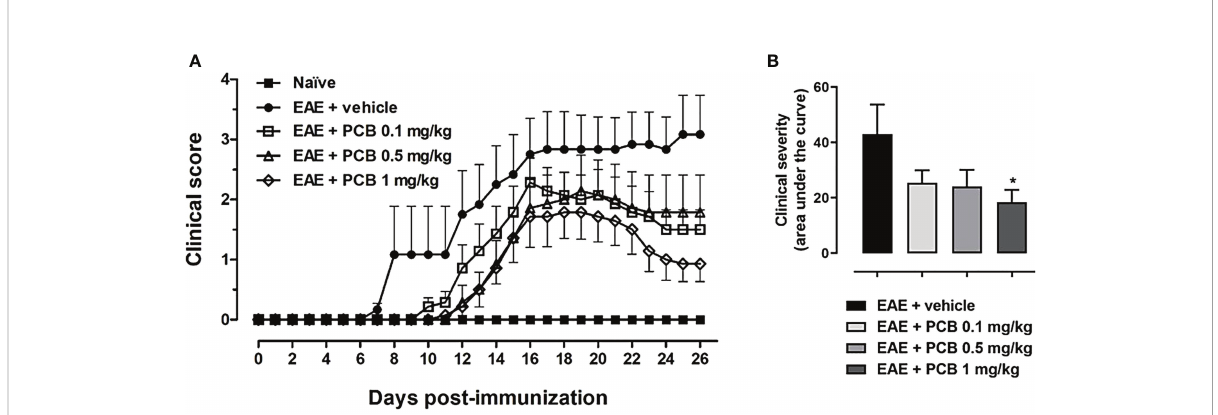
FIGURE 1 Effect of PCB in a murine model of chronic progressive EAE. (A) Daily clinical assessment of the mice. (B) Clinical severity determined by the area under the curve (in arbitrary units). MOG 35 – 55 immunized mice received a daily i.p. injection of PBS (vehicle) or PCB at 0.1, 0.5 or 1 mg/kg, from day 0 until day 26 post-immunization. A numeric scale with the ascending graveness was used to score every day the clinical signs of the mice, ranging from 0 (no disease) to 5 (death). The naïve group (non-immunized animals) remained healthful during the entire study period (score 0). Data are expressed as the mean ± S.E.M (n=6-7 per group). The asterisk (*) is indicative of signi fi cant differences with vehicle-treated EAE mice (*p<0.05, ANOVA + Newman-Keuls